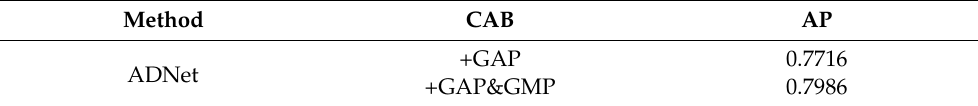
Table 2. Comparison of different attention methods.